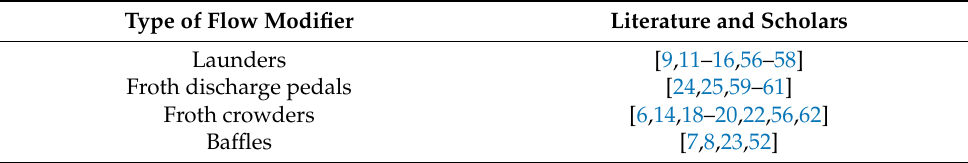
Table 2. Types of physical froth flow modifiers.